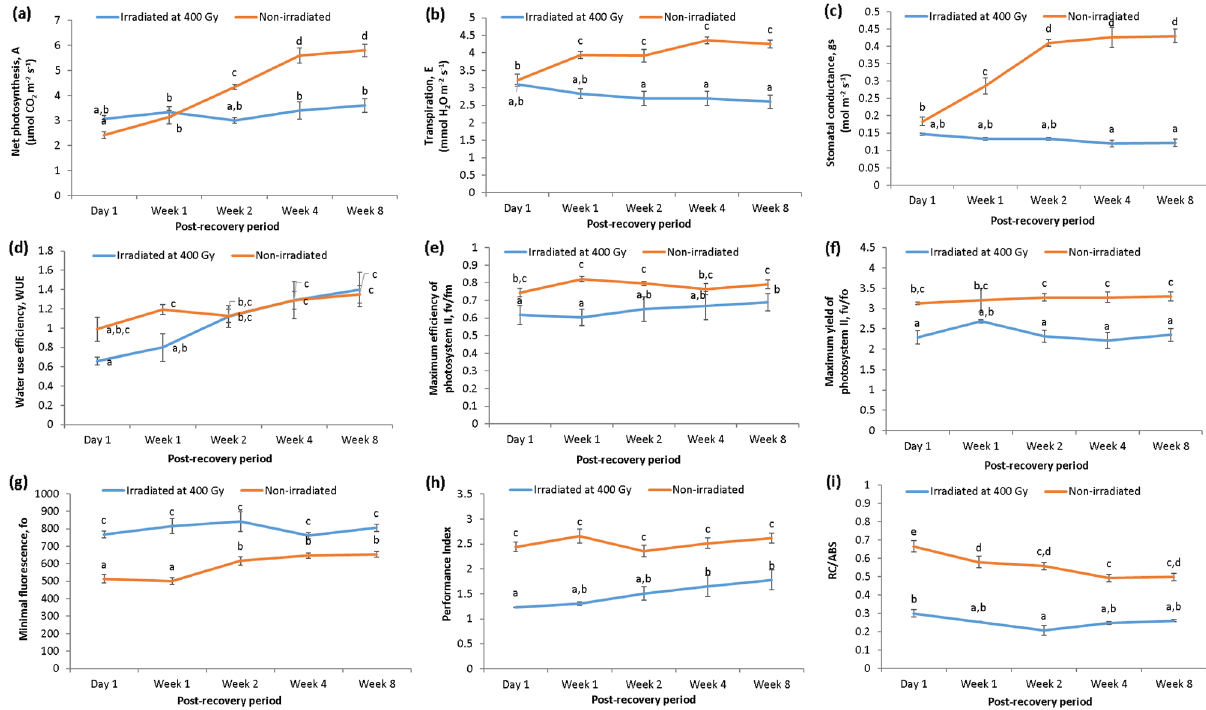
Figure 3. ( a ) Net photosynthesis, ( b ) transpiration rate, ( c ) stomatal conductance, ( d ) water use efficiency, ( e ) maximum efficiency of photosystem II, ( f ) maximum yield of photosystem II, ( g ) minimal fluorescence, ( h ) performance index, and ( i ) RC/ABS (density of reaction centre per PSII antenna) of non-irradiated and irradiated A. comosus plantlets at five different post-recovery